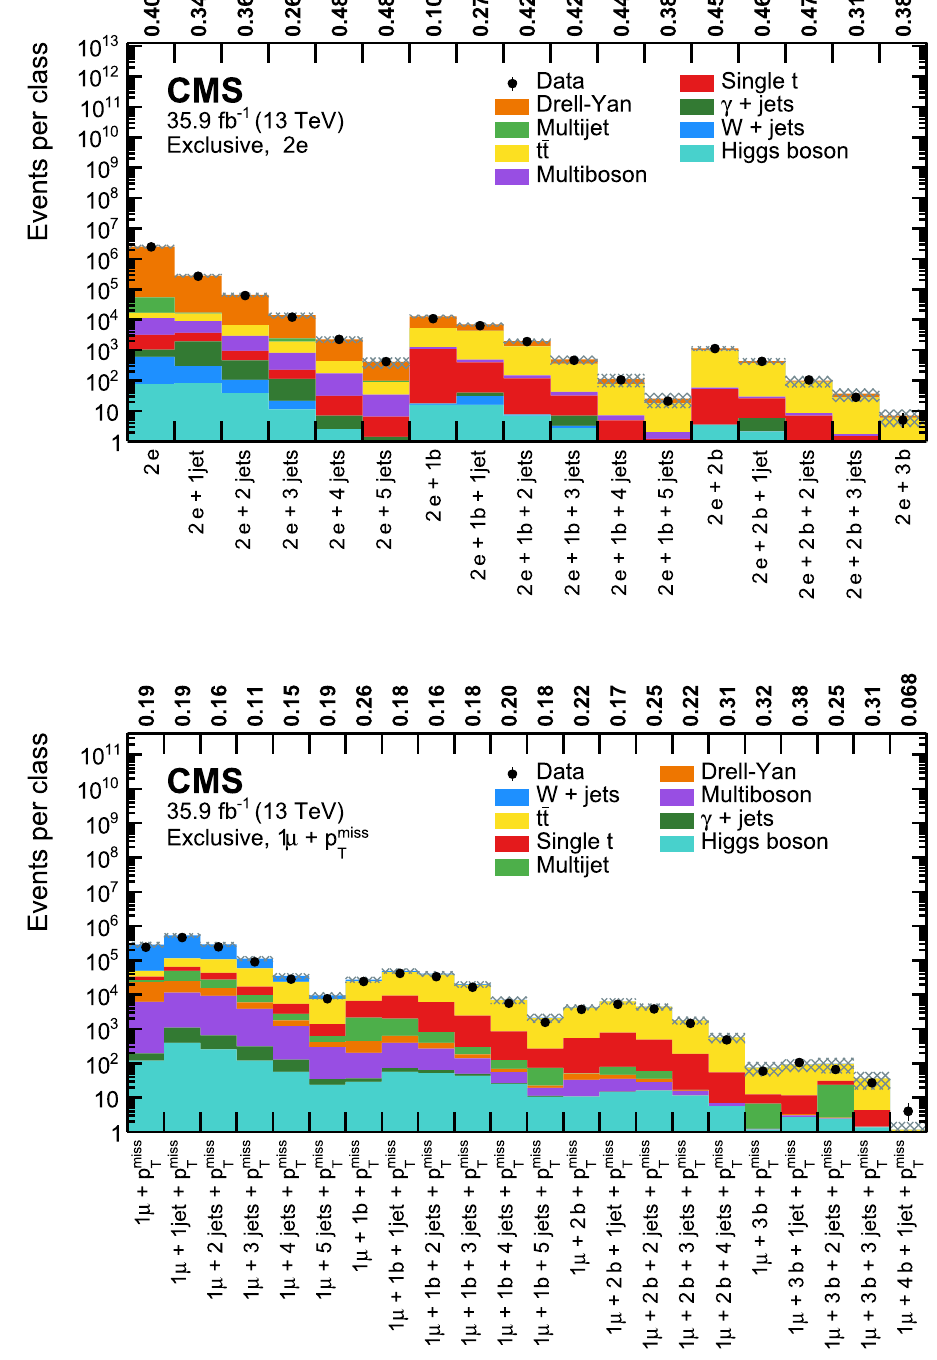
Fig. 9 Overview of total event yields for event classes corresponding to the double-electron (upper) and for the single-muon + p miss object T groups (lower). Measured data are shown as black markers, contributions from SM processes are represented by coloured histograms, and the shaded region represents the uncertainty in the SM background. The numbers above each plot indicate the observed p value for the agreement of data and simulation for the corresponding event